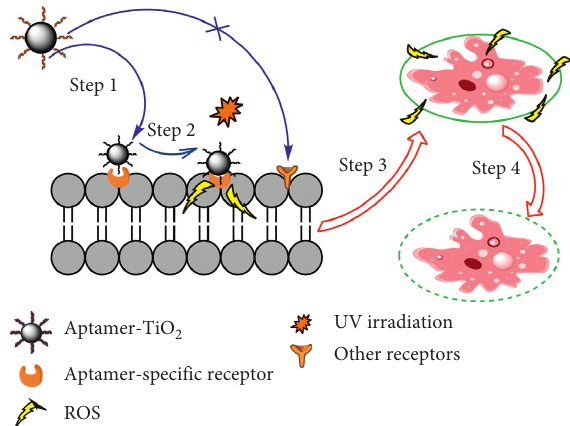
Figure 1: Schematic diagram of antibacterial mechanism of aptamer- TiO 2 . Step 1: TiO 2 particles conjugated with aptamer bind on the cellular surface. The aptamer specifically recognizes its receptor on the bacterial surface to make the TiO 2 particles closely contact with the cell membrane. Step 2: TiO 2 is excited under UV irradiation to generate electrons on its surface and produce reactive oxygen species (ROS). Steps 3 and 4: ROS causes oxidative damage to bacteria by disrupting the cell wall or damaging DNA/RNA and